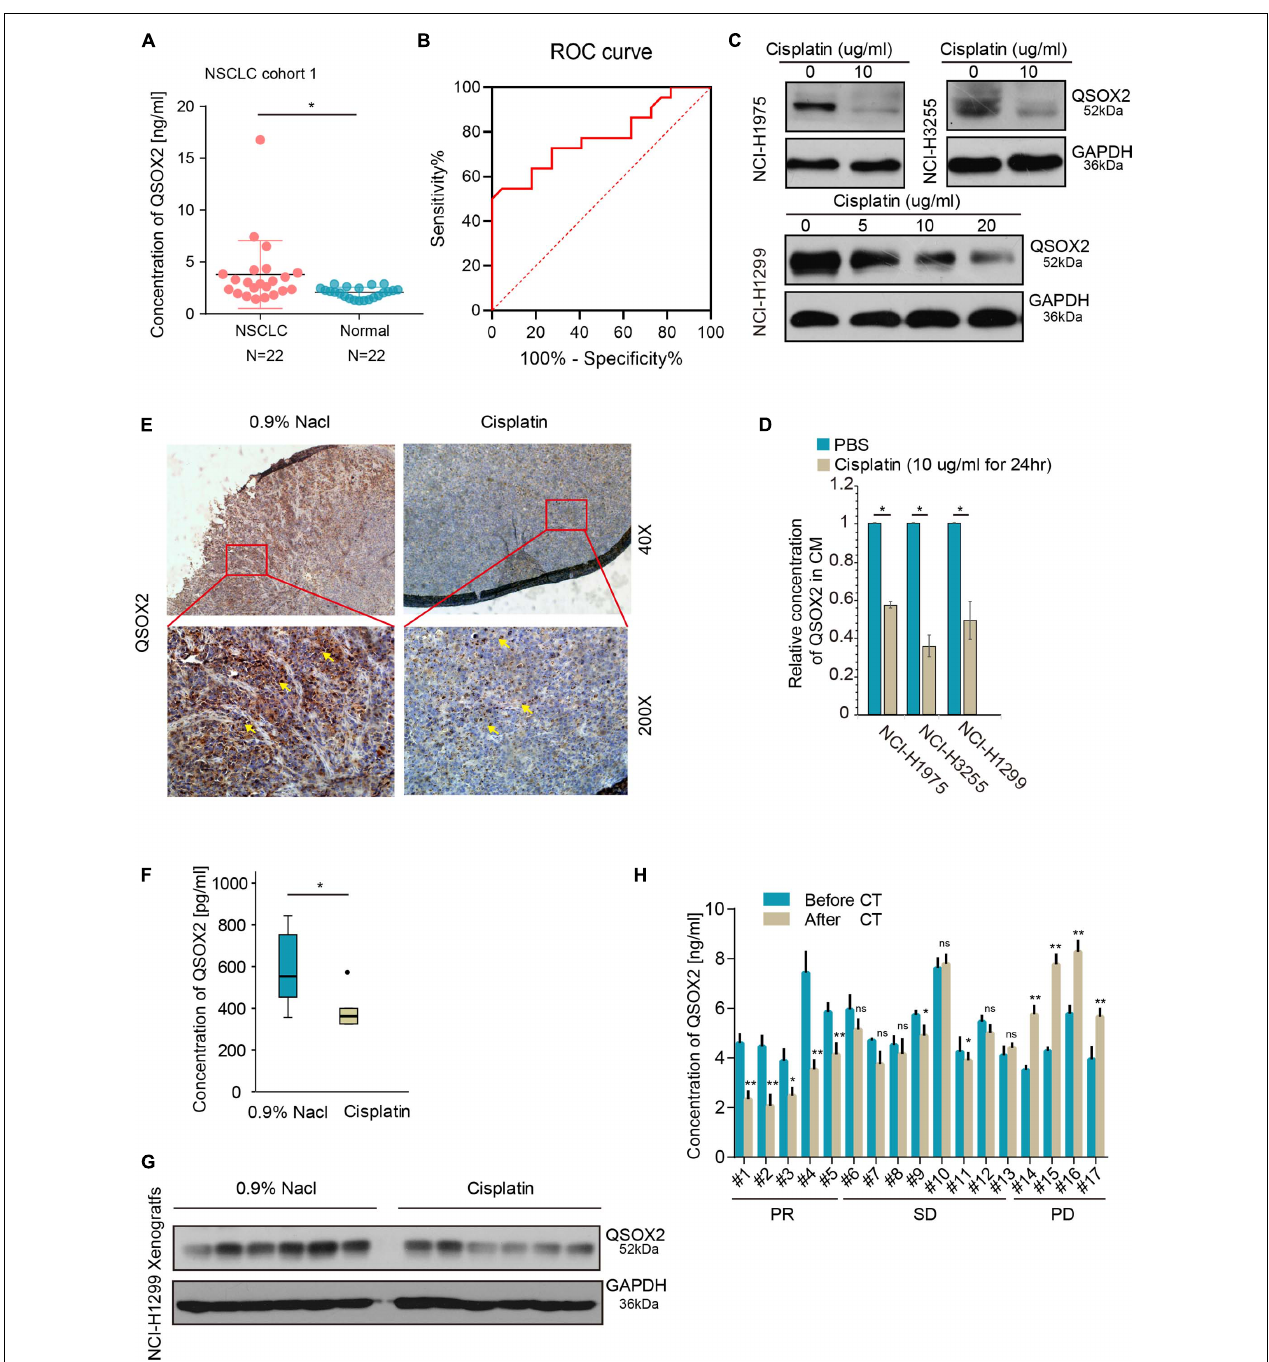
FIGURE 2 | Quiescin sulfhydryl oxidase 2 ( QSOX2 ) can be used as a circulating marker to monitor tumor growth. (A) Serum samples were collected from 22 patients in cohort 1 and 22 healthy persons and subjected to ELISA analysis for QSOX2 expression; * P < 0.05. (B) ROC curve analyses of QSOX2 signature to discriminate NSCLC patients from healthy persons. (C) NCI-H3255 and NCI-H1975 cells were treated with cisplatin (10 µ g/ml) for 24 h, NCI-H1299 cells were treated with a graded dose of cisplatin (5/10/20 µ g/ml) for 24 h, and all cells were harvested for WB analysis with an anti-QSOX2 antibody. (D) Concentrated cell culture medium supernatant from panel (C) was harvested and subjected to ELISA analysis for QSOX2 expression; * P < 0.05. (E) Representative QSOX2 -stained sections from 0.9% NaCl- or cisplatin (5 mg/kg)-treated xenografts are shown. The yellow arrow represents QSOX2. (F) The boxplot compares the QSOX2 level in the serum of tumor-bearing mice treated with or without cisplatin; * P < 0.05. (G) The xenografts from were harvested for Western blot (WB) analysis with the anti-QSOX2 antibody. (H) The expression levels of QSOX2 were compared before and after 2 cycles of cisplatin-based chemotherapy. Then, sera were harvested from 17 NSCLC patient and subjected to ELISA and WB analysis for QSOX2 expression, * P < 0.05 and ** P < 0.01.